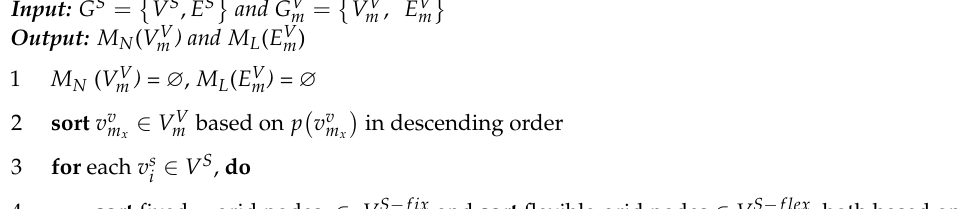
Algorithm 1 Flexible-Grid Aware-Virtual Network Embedding Algorithm